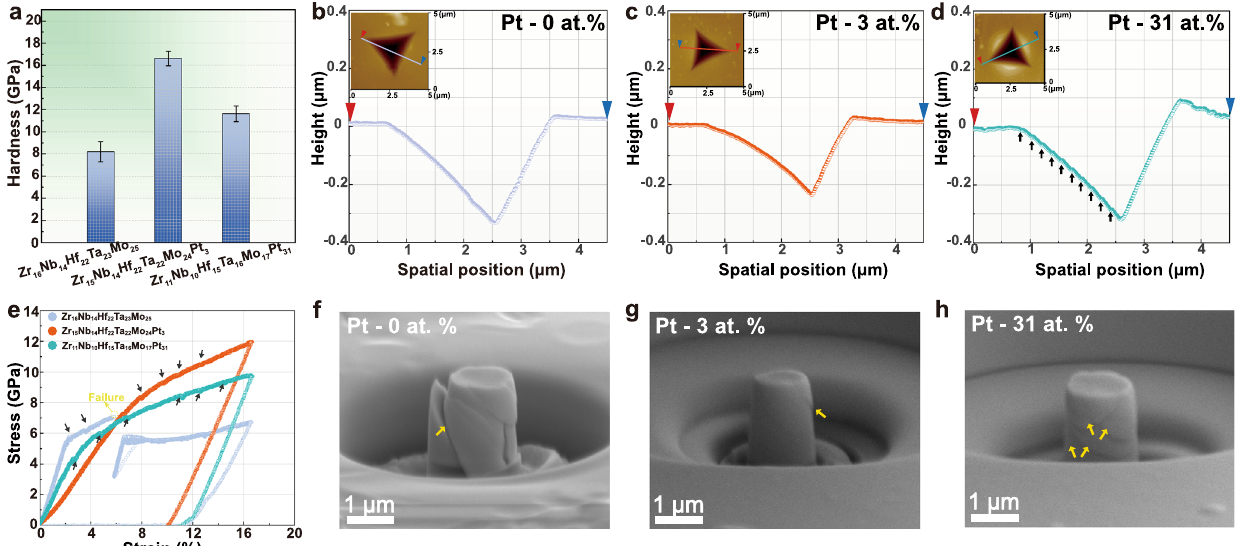
Fig.3|ComparisonofmechanicalpropertiesoftheZr – Nb – Hf – Ta – MoHEAwith other Pt-bearing HEAs. a The hardness results of three HEAs (Pt-free, Pt-3%, Pt- 31%). The Pt-3% HEA with the paracrystalline structure exhibits excellent hardness. Errorbarsrepresentstandarddeviation. b – d Cross-sectionalpro fi lesofthe indent, along the colored lines of the corresponding inset images (red and blue triangles represent the beginning and end of the pro fi le respectively). A large number of offsets(markedbyarrows)correspondingtoshearbands(SBs)andthelargepileup